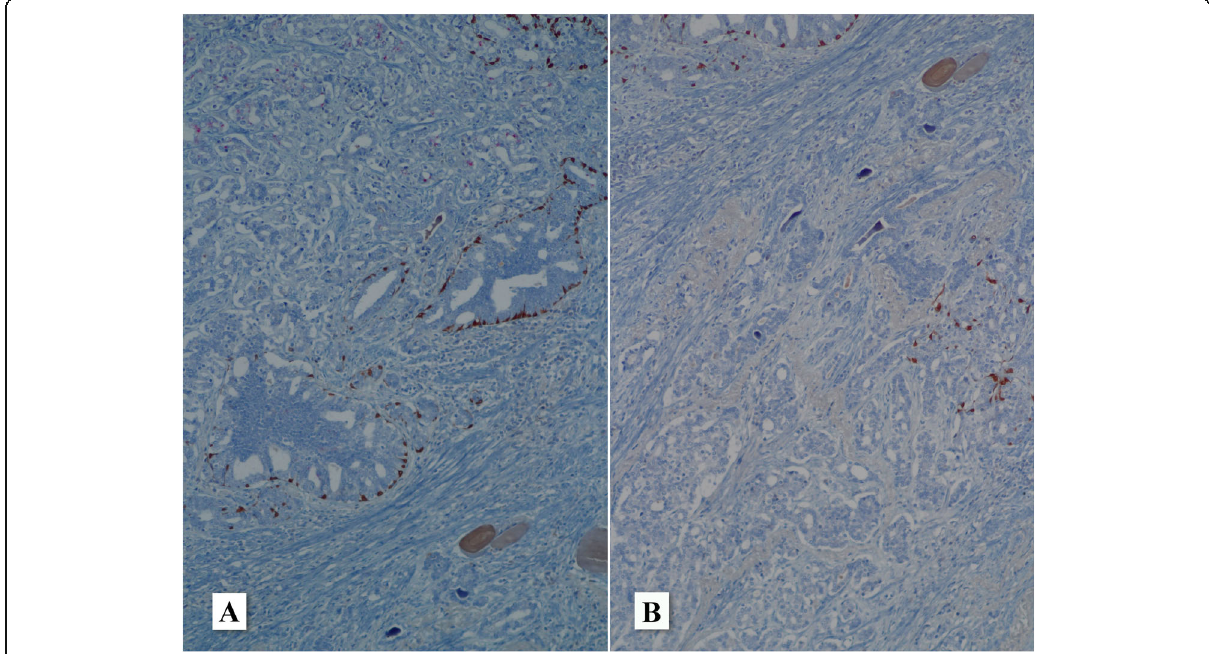
Fig. 5 Triple cocktail showing small cell-like change in intraductal carcinoma and invasive prostatic adenocarcinoma. The monotonous small cell proliferation is seen within intraductal carcinoma, with preserved basal cell layer ( A ), and within invasive adenocarcinoma – with no basal cells ( B ). Immunohistochemistry for p63 and high molecular weigh cytokeratin (brown) and alpha-methylacyl-CoA racemase (red): A (100x) and B